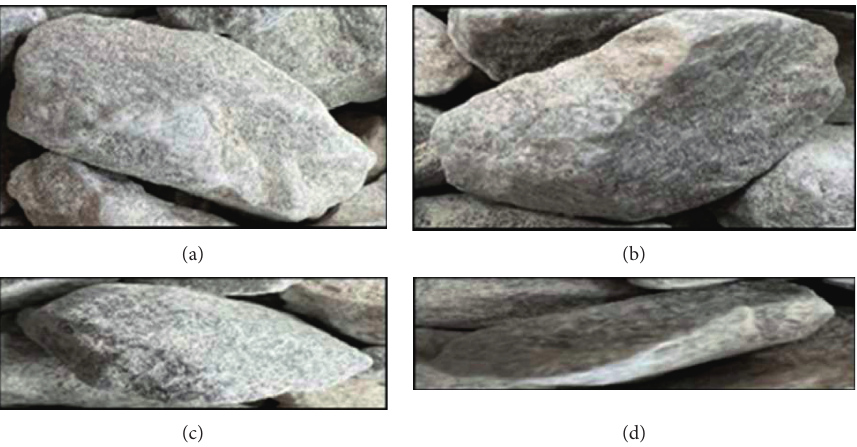
Figure 3: Schematic of stretching images: (a) 1.5:1 image; (b) 2:1 image; (c) 3 :1 image; (d) 4 :1 image.